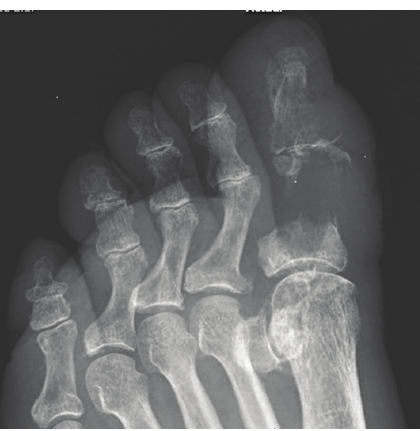
Figure 1: X-ray of right foot showing erosive and lytic lesion with cortical disruption in the proximal phalanx of the right hallux associated with soft tissue swelling.